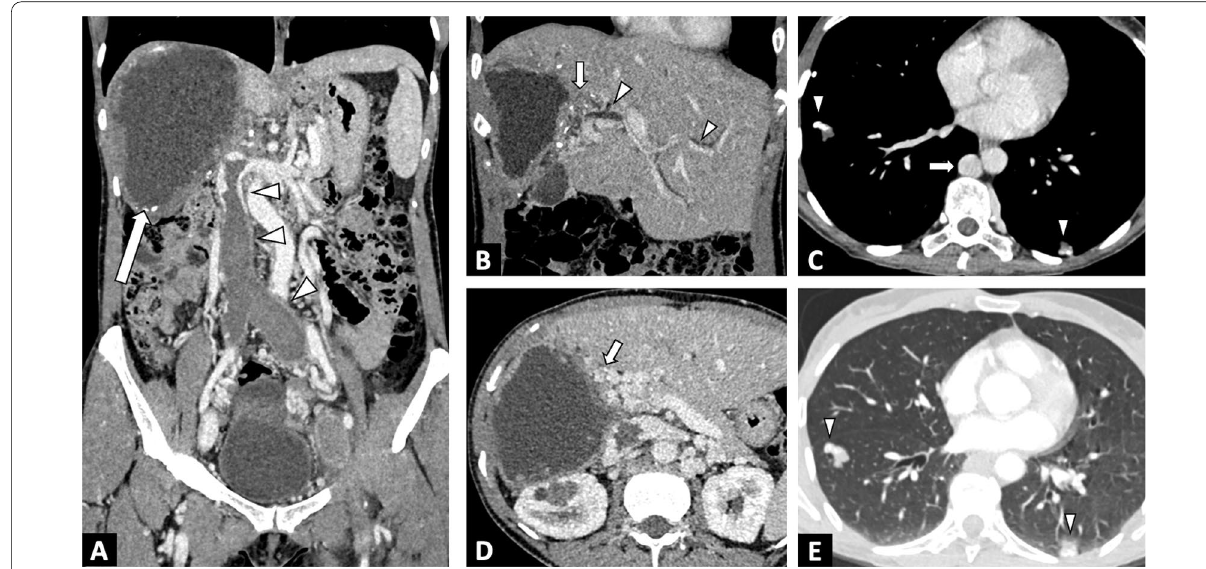
Fig. 10 Alveolar echinococcosis lesion of the right liver in a 49‑year‑old woman discovered due to left leg edema. A CT image in the coronal plane at the portal phase showing alveolar echinococcosis of the right liver (arrow) associated with invasion of the inferior vena cava, responsible for thrombosis, extending to the common iliac veins (arrowheads). B CT image in the coronal plane obtained during the portal phase: infiltration to the pedicle and biliary convergence (arrows) and biliary dilatation of the left lobe (arrowheads). C CT image in the axial plane obtained during the portal phase showing portal cavernoma of the liver pedicle secondary to hilar alveolar echinococcosis infiltration. D Same examination, soft tissue window: calcified lung nodules (arrowheads). Hypertrophy of the azygos vein secondary to inferior vena cava thrombosis (arrow). E Same examination, lung window: calcified lung nodules